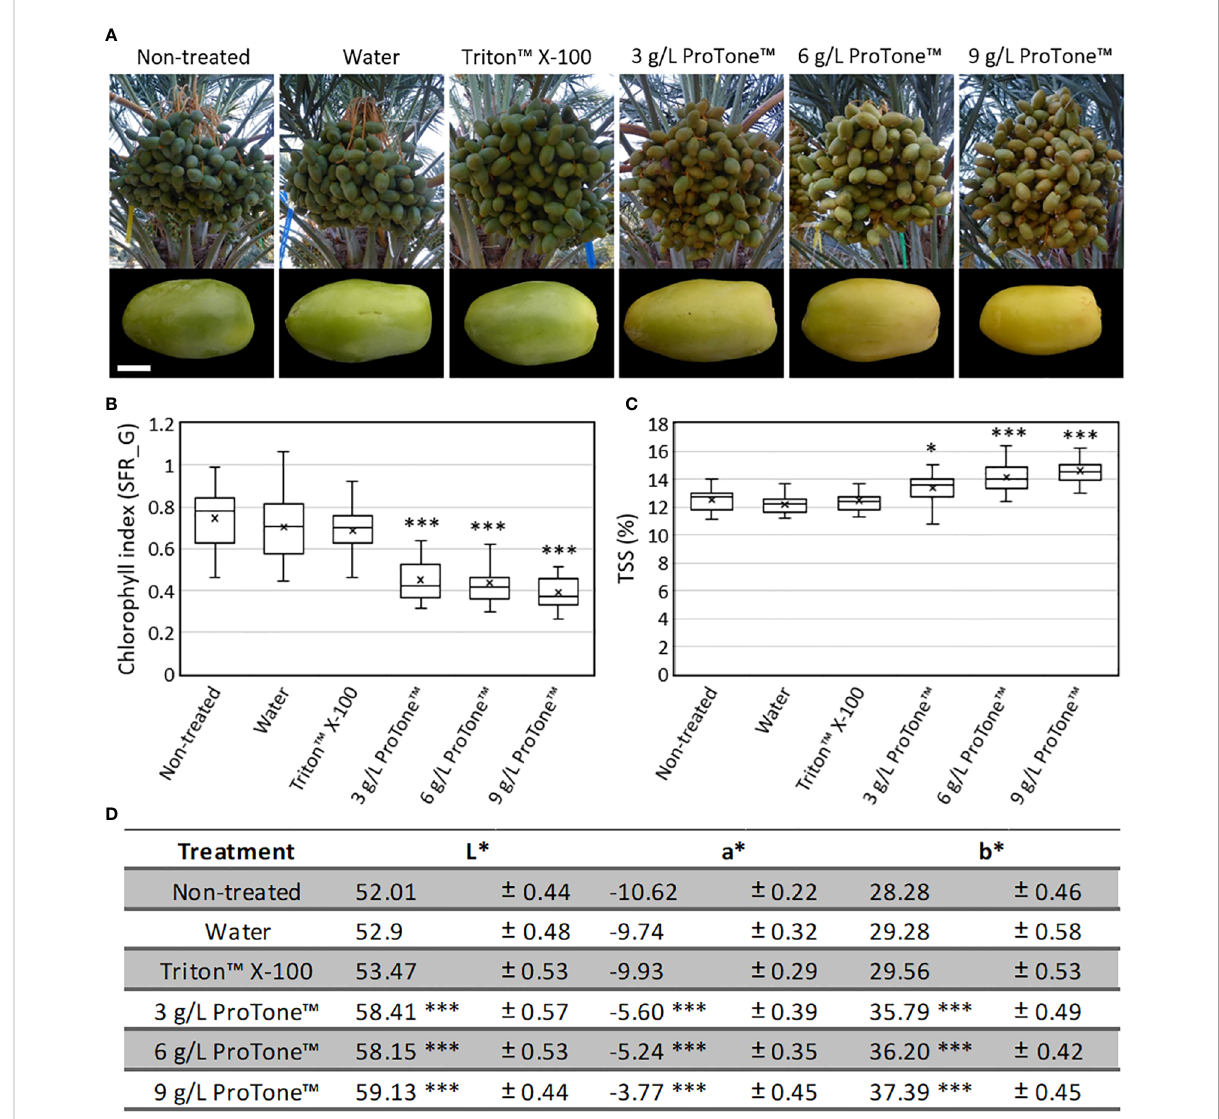
FIGURE 6 Effects of exogenous ABA treatment on date fruit maturation. Whole date fruit clusters were treated every three days (four treatments in total) with 3, 6 or 9 grL -1 ProTone ™ (ABA), starting at 17 WPP, on the tree (Gro fi t 2020; A ; upper panel). Representative fruits per treatment were sampled and photographed one week after the last treatment (A ; lower panel ) . Fruit ripening was characterized through quanti fi cation of (B) chlorophyll relative fl uorescence, (C) total soluble solids ( TSS; D) and the L*a*b* color space parameters. Error bars and “ ± ” indicate standard error. All data were analyzed using Tukey-Kramer multiple comparison test (B, C, D) ; * indicates p-value < 0.5; *** indicates p-value < 0.0001. The number of fruits measured per treatment at each time point was